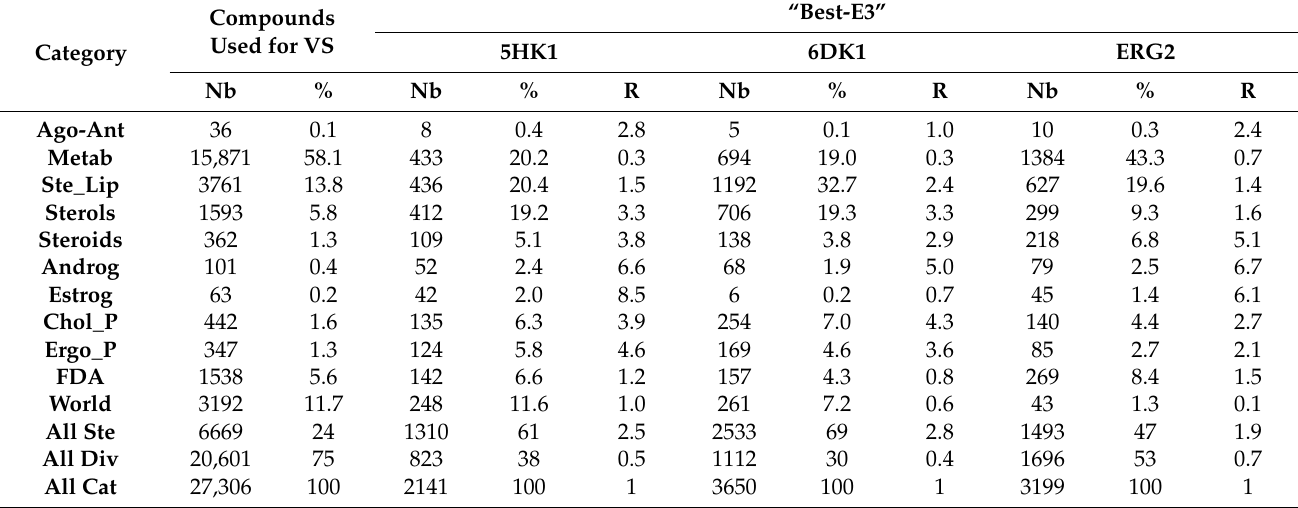
Table 2. Comparison between the percentage of compounds in each category used for VS against the 3D structures of Hs σ 1-R in coordinate files 5HK1 and 6DK1, or the molecular model of yeast ERG2, and the percentage of compounds in the same categories found in the “best-E3” subset obtained from VS against each structure. 5HK1_A and 6DK1_A: monomer with chain ID “A” in coordinate files 5HK1 and 6DK1, respectively. ERG2: molecular model of yeast ERG2 protein built by AlphaFold2. Category: category of compounds included in the complete 21,359 dataset used for VS against these structures. Ago-Ant, Metab, Ste_Lip, Sterols, Steroids, Androg, Estrog, Chol_P and Ergo_P, FDA and World are as in Table 1. All Ste, All Div and All Cat: all steroid-based compounds (comprising Ste_Lip, Sterols, Steroids, Androg, Estrog, Chol_P and Ergo_P), all compounds with diverse scaffolds (comprising Metab, FDA and World) and all compounds in all categories. Note that the sum of compounds in All Cat is higher than 21,359, which is the total number of compounds used for VS against 5HK1_A, 6DK1_A and ERG2, because many compounds belong to more than one category and, therefore, are counted more than once. Nb and %: number and percentage of compounds in each category. R: ratio between the percentage of compounds in each category comprised in the “best-E3” subset resulting from VS and the total percentage of compounds in each category given as input to the “best-E3” subset with respect to the total percentage of compounds in the same category used for VS. R values < 1 indicate that compounds in a given category are under-represented within the “best-E3”